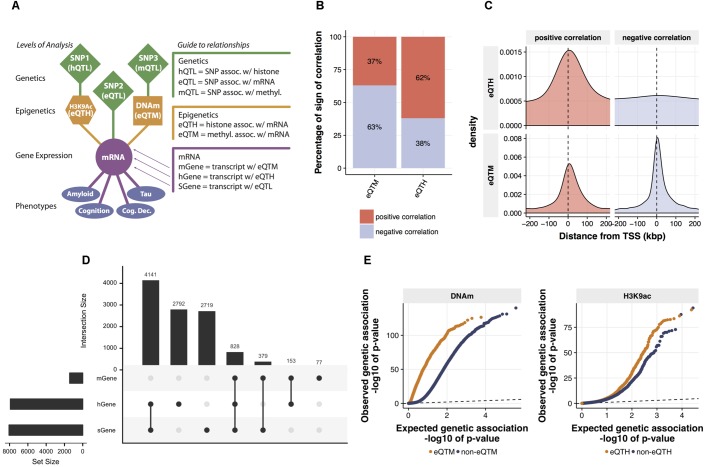
Identification and characterization of relations between mRNA expression and cis-regulatory signals. (A) The map of cross-omics associations in DLPFC. The cis-regulatory associations across mRNA levels, H3K9ac peaks, DNA methylation (DNAm) sites, and SNPs were assessed via linear regression (FDR < 0.05). Brain phenotypes associated with mRNA levels were assessed via Spearman’s correlation (FDR < 0.05). (B) Proportions of a sign of the correlation between mRNA levels and both eQTMs and eQTHs. (C) Distribution of eQTM and eQTH in relation to transcription start site. (D) The intersection of genes associated with cig-regulatory signals. Genes associated with at least one SNP (FDR < 0.05), genes associated with at least one DNA methylation locus (FDR < 0.05), and genes associated with at least one H3K9ac peak (FDR < 0.05) are defined as sGene, mGene, and hGene, respectively. To visualize the number of overlapped genes, UpSet plot was used. The horizontal bar plot represents the total number of sGene, hGene, or mGene. The vertical bar plot represents the number of genes shared among combinations of sGene, hGene, and mGene. For instance, the first column indicates the number of genes shared between hGene and sGene and the forth column indicates the genes shared by all three groups. This “UpSet” plot was generated using UpSetR software (Conway et al., 2017). (E) Quantile–quantile (Q-Q) plots of genetic associations of DNAm sites and H3K9ac peaks stratified by their associations to mRNA levels. The significance of genetic associations was assessed via linear regression using FastQTL software with 1,000 times permutation.